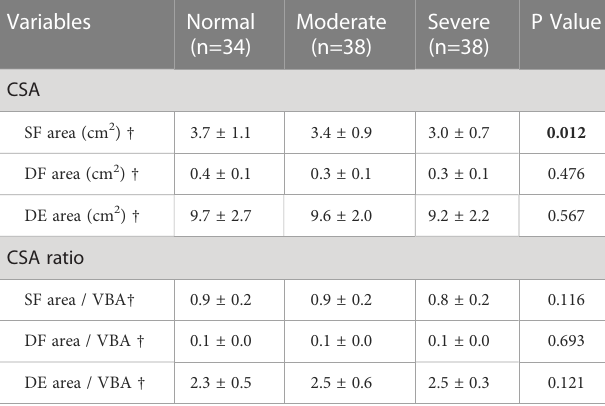
TABLE 4 Relationship between fatty in fi ltration and CSA.